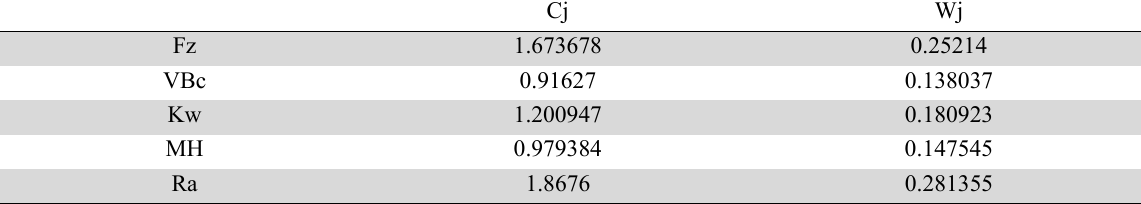
Weights for the output responses estimated by using CRITIC